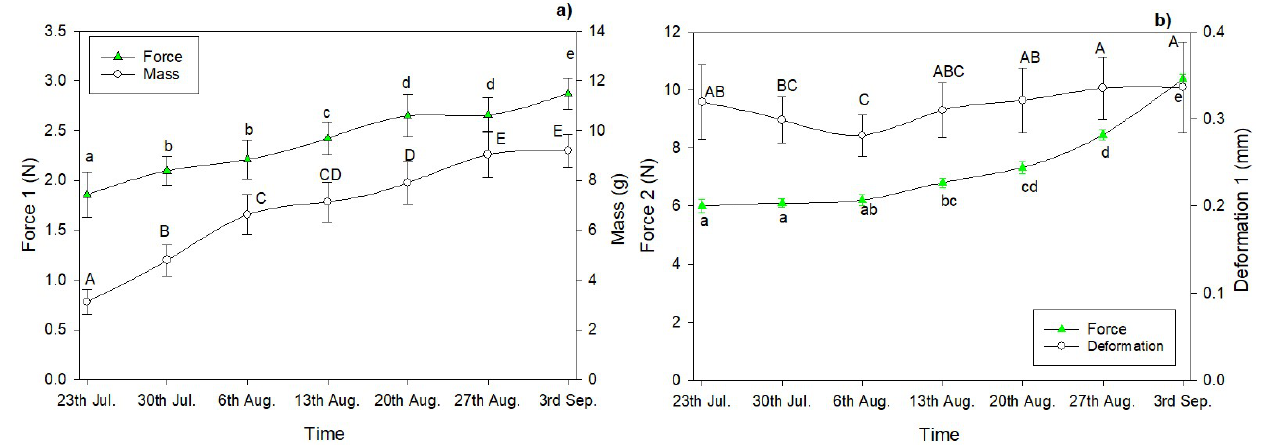
Figure 3. Changes in shell hardness (Force 1, Force 2), deformation at fracture (Deformation 1) and average mass of acorns harvested from 23 July to 3 September: different letters indicate significant differences (Tukey’s HSD, p < 0.05) in shell hardness—Force 1 ( a ) or Force 2 ( b ); different capital letters indicate significant differences (Tukey’s HSD, p < 0.05) between masses ( a ) or Deformation 1 ( b ) of